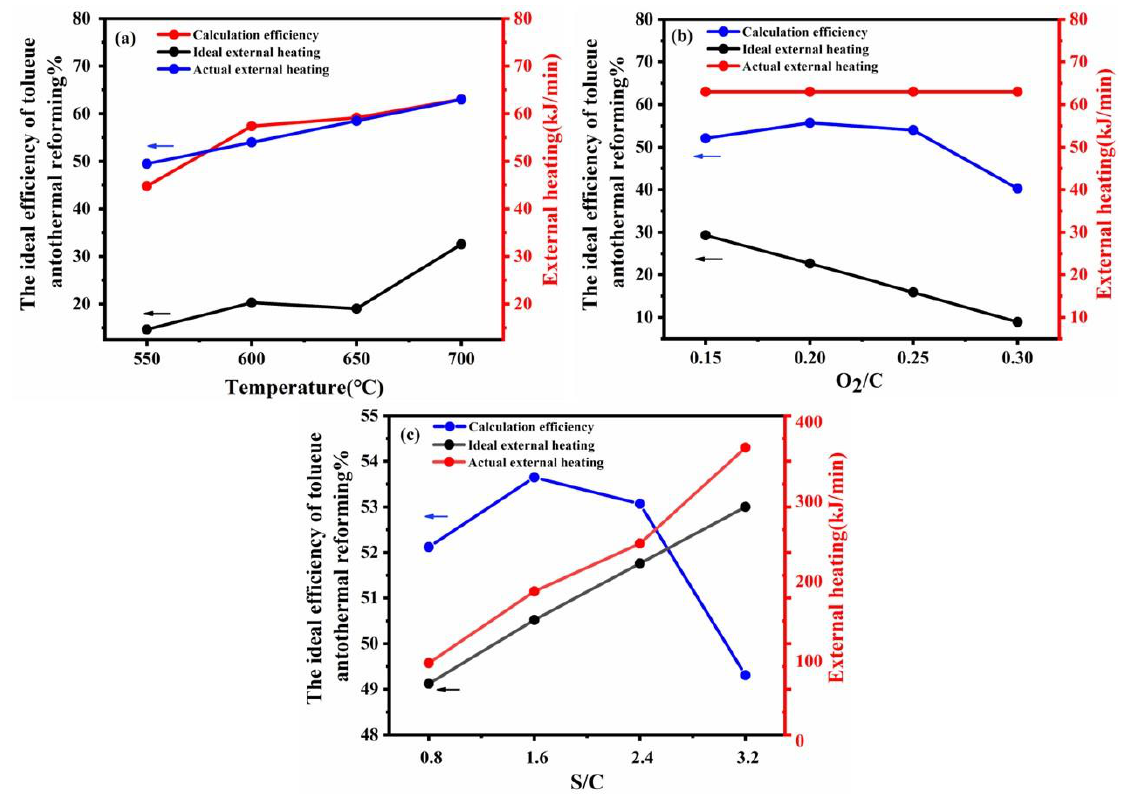
Figure 7. Theoretical efficiency calculation of autothermal reforming and external heating reforming at different temperatures ( a ), different O 2 /C molar ratios ( b ), and different S/C molar ratios ( c ).